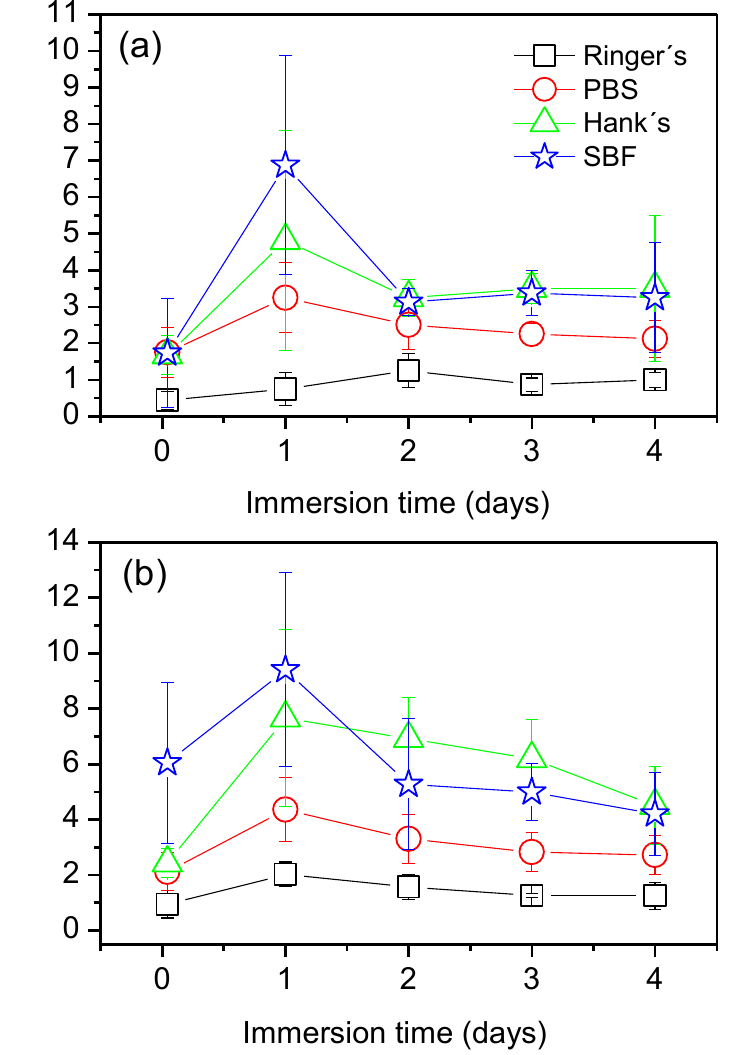
Figure 8. ( a ) Variations in polarization resistance (R p ) and ( b ) charge transfer resistance (R t ) values as a function of the immersion time in Ringer’s, PBS, Hank’s, and SBF solutions. The B ′ values associated with corrosion of the AZ31B Mg alloy in the four simulated body fluids were estimated by the linear fitting of the mean values of the anodic charge, which were taken from the weight loss measurements as a function of the time-integrated reciprocal of the mean values of R p and R t determined by EIS from 1 h to a maximum of 4 days of immersion (shown in Figures 9 and 10) [16,23].